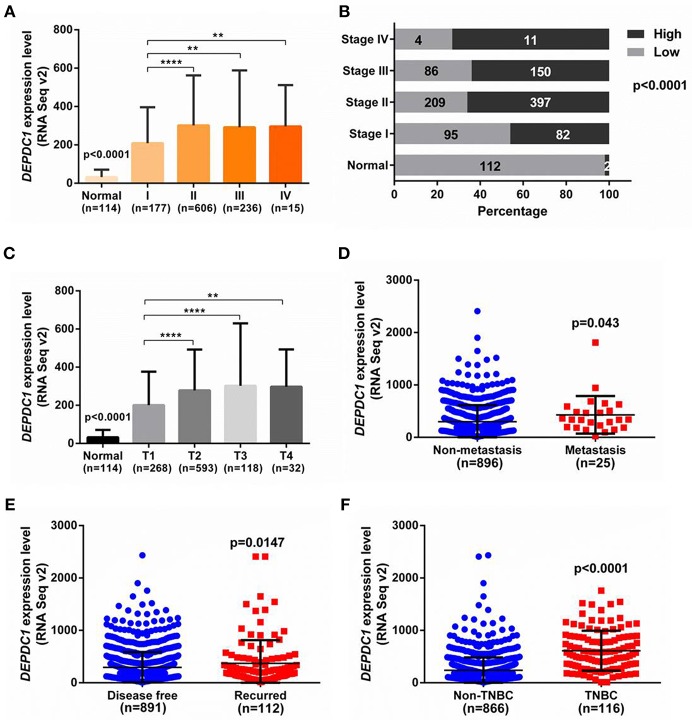
The association of DEPDC1with advanced stage, metastasis and malignant degree of breast cancer was analyzed from TCGA_BRCA dataset. (A) Correlation analysis was performed between expression level of DEPDC1 and clinical AJCC stages. DEPDC1 was correspondingly increased with the increase of clinical AJCC stage of breast cancer. (B) Constituent ratio with high level of DEPDC1 was drastically different between normal samples and I, II, III, or IV stage of breast cancer tissues. (C) DEPDC1expression level was increased as breast cancer tumor size (T) growth and distant metastatic relapse status (D) from TCGA_BRCA data. (E) Scatter plot of relative DEPDC1 mRNA level in breast cancer patients with and without recurrence was compared. (F) The expression of DEPDC1 was higher in TNBC than in non-TNBC of breast cancer. *p < 0.05, **p < 0.01 and ****p < 0.0001.